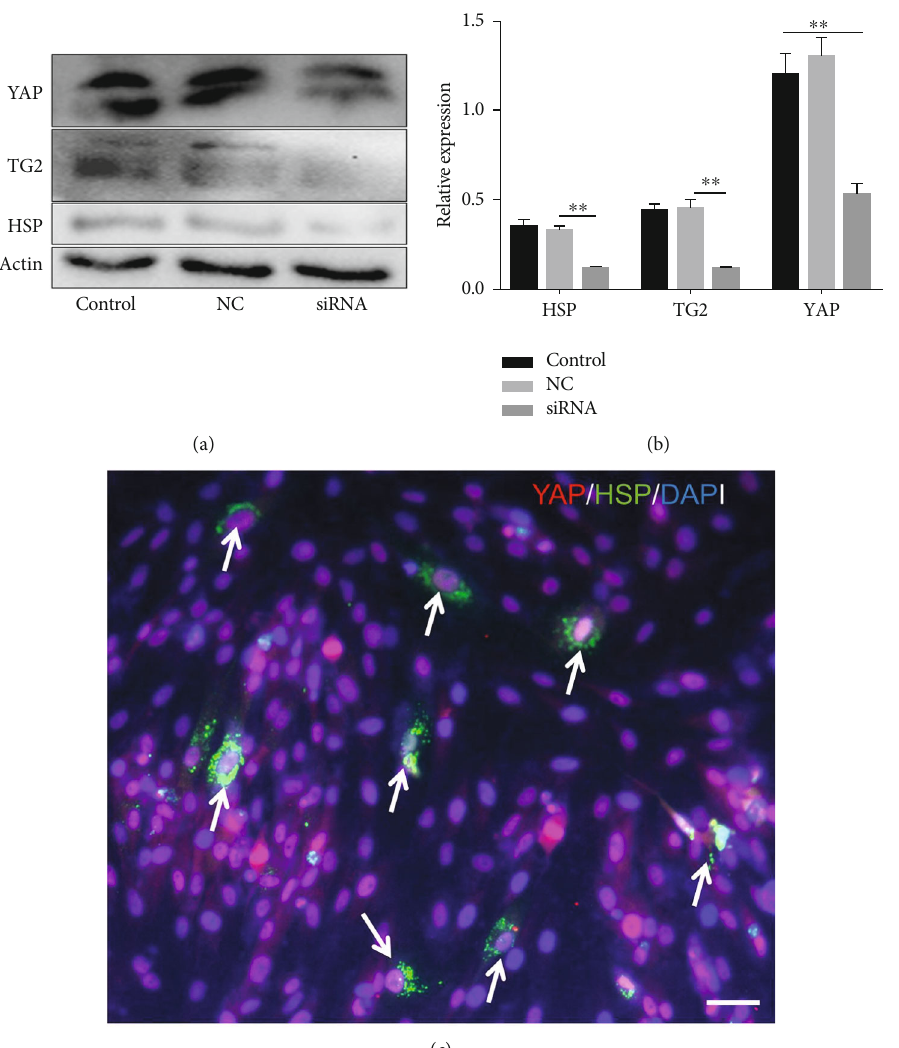
Figure 8: YAP induces TG2 and HSP activation. Heat shock induces YAP nuclear translocation and expression. YAP, HSP, and TG2 levels were detected by western blotting (a), and representative pictures from three independent samples are shown (b). (c) HSP colocalizes with YAP in the